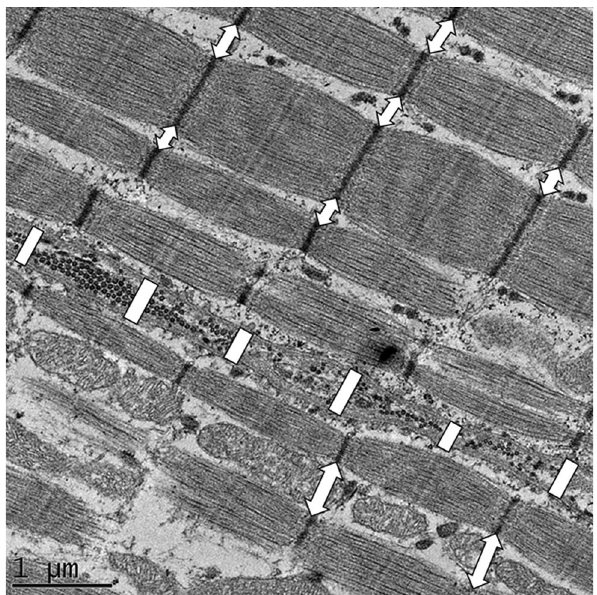
Figure 2. TEM measurements method. Electron microscopic image showing measured distance between cells (lines) and myofibrils (double arrows); distance of phospholipid membranes measured in 1–2 μm gradients and at the level of Z lines of